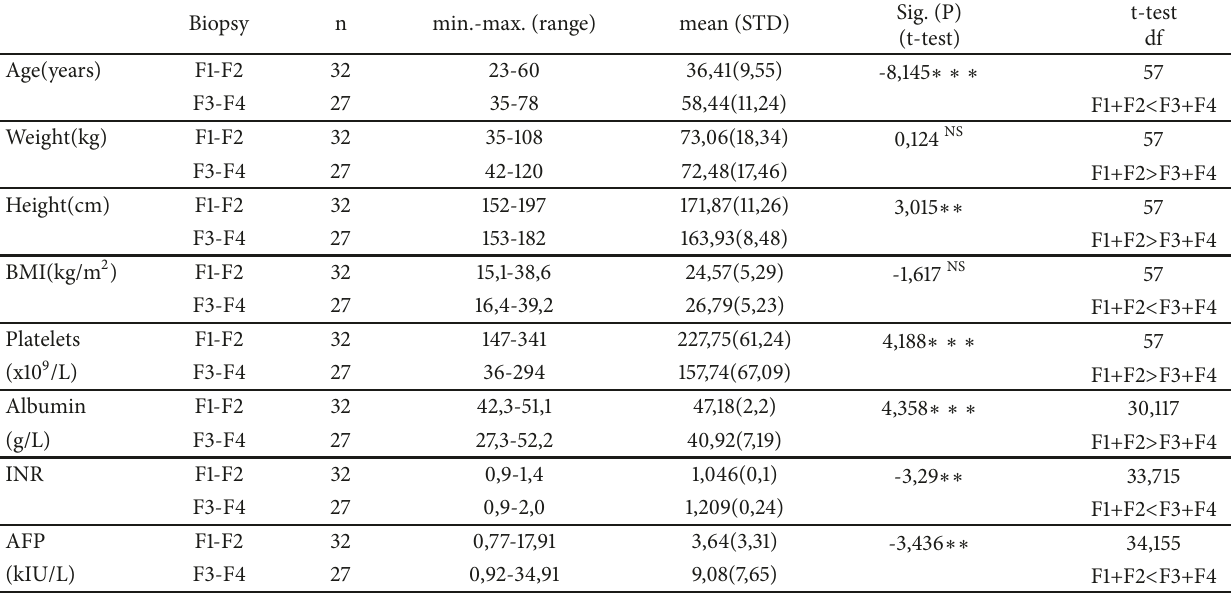
Table 2: Baseline parameters of the study cohort.